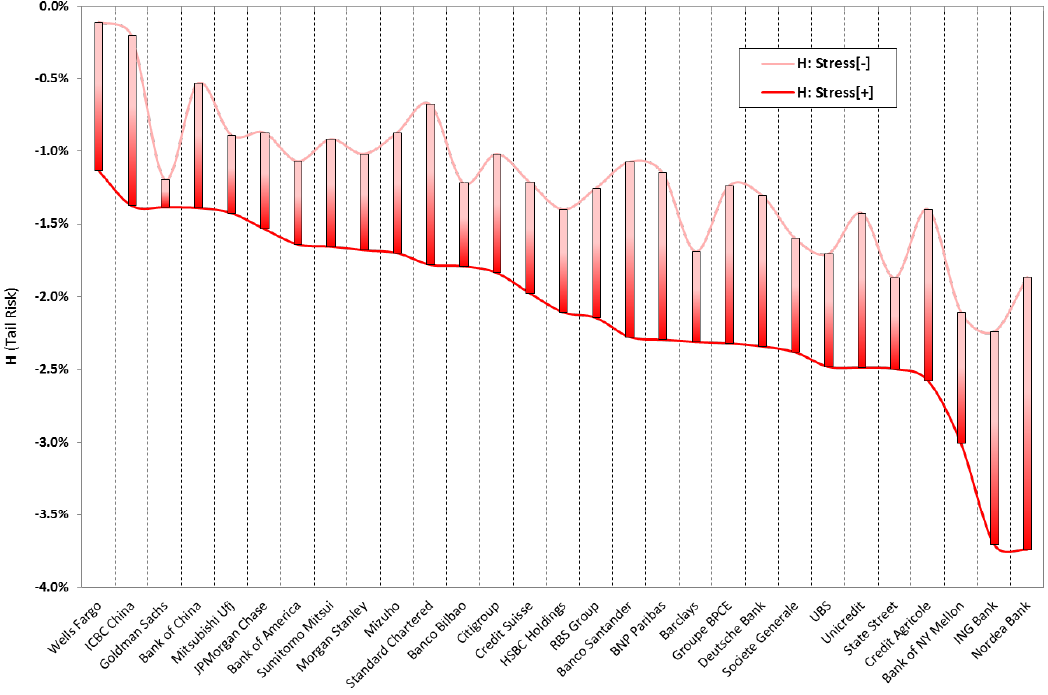
Figure 7. Heuristic measure of tail risk (CET1 ratio — 2015).